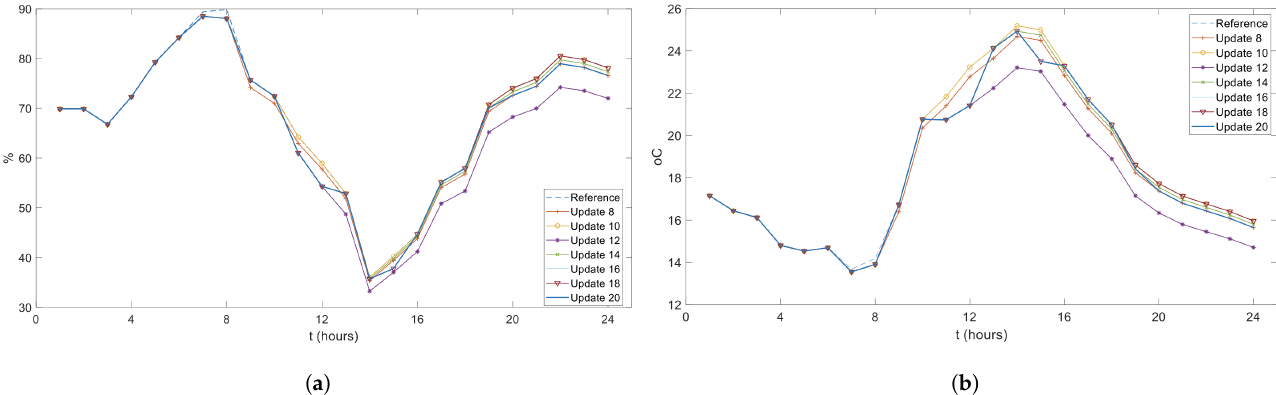
Figure 13. Real-time deviations from the day-ahead forecast of ( a ) relative humidity; ( b )